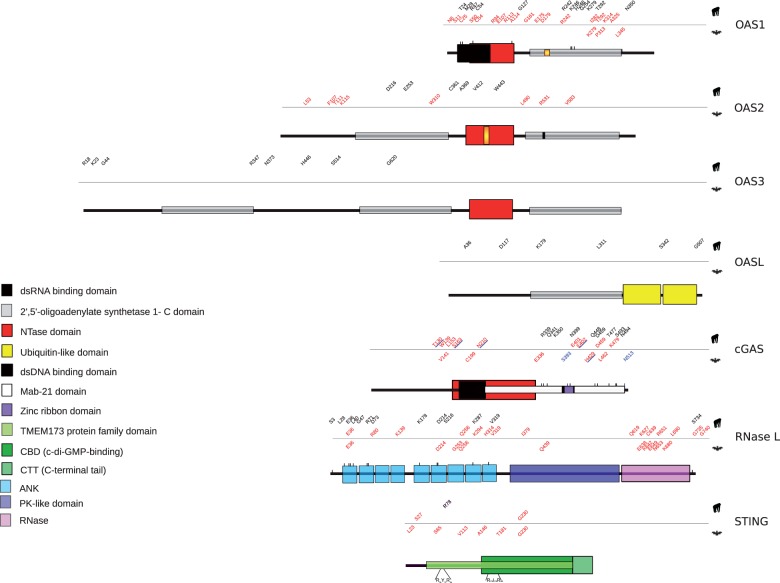
Schematic representation of the domain structure of OASs family members, cGAS, RNase L, and STING. Domains are color-coded as reported in the legend (left). The position of positively selected sites is shown and color-coded as follows: Red, positively selected sites in the primate or bat phylogenies; blue, lineage-specific positively selected sites; black, positively selected sites in the human, chimpanzee, or gorilla lineages.